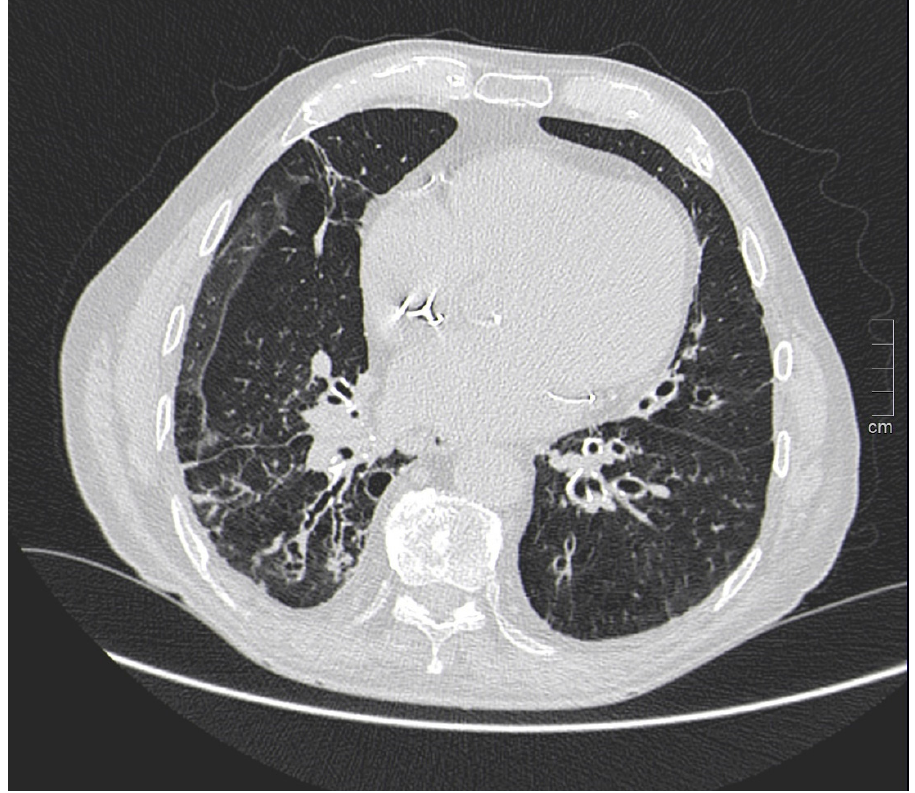
Figure 5. Arrow shows di ff use thickening of the bronchial wall in a former-smoker woman with